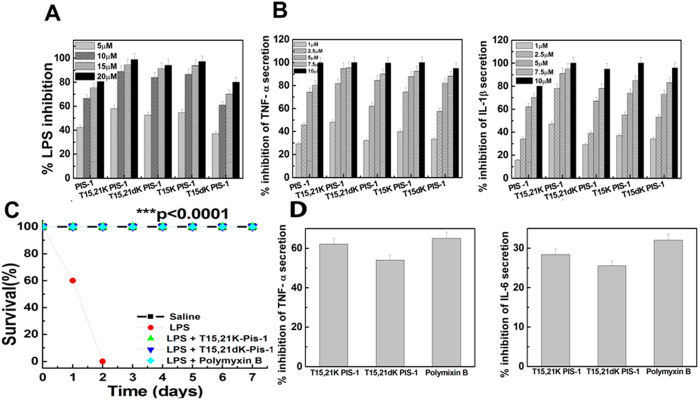
(A), Dose dependent LPS neutralization by the piscidin-1 and its analogs as determined by LAL assay; (B) the percentage inhibition of levels of LPS-induced secretions of TNF-α and IL-1β, respectively, in the presence of piscidin-1 and its analogs by ELISA experiments; (C) In vivo anti-LPS activity of the peptides in mice. Septic shock in BALB/c mice was induced by intraperitoneal (i.p.) injection of E. coli LPS (12 mg/kg) followed by i.p. injection of T15,21K-piscidin-1 (0.5 mg/Kg) or T15,21dK-piscidin-1 (1 mg/Kg) or polymyxin B (1 mg/Kg) ~5 min later. Mice treated with only saline was taken as control. Survival of the animals (n = 5) was monitored for 7 days (***p < 0.0001, log-rank test). (D) Percentage inhibition of TNF-α and IL-6 in LPS (12 mg/Kg) treated mice serum in the presence of piscidin-1 analogs T15,21K-piscidin-1 (0.5 mg/Kg), T15,21dK-piscidin-1 (1 mg/Kg) and polymyxin B (1 mg/Kg) by ELISA experiments.